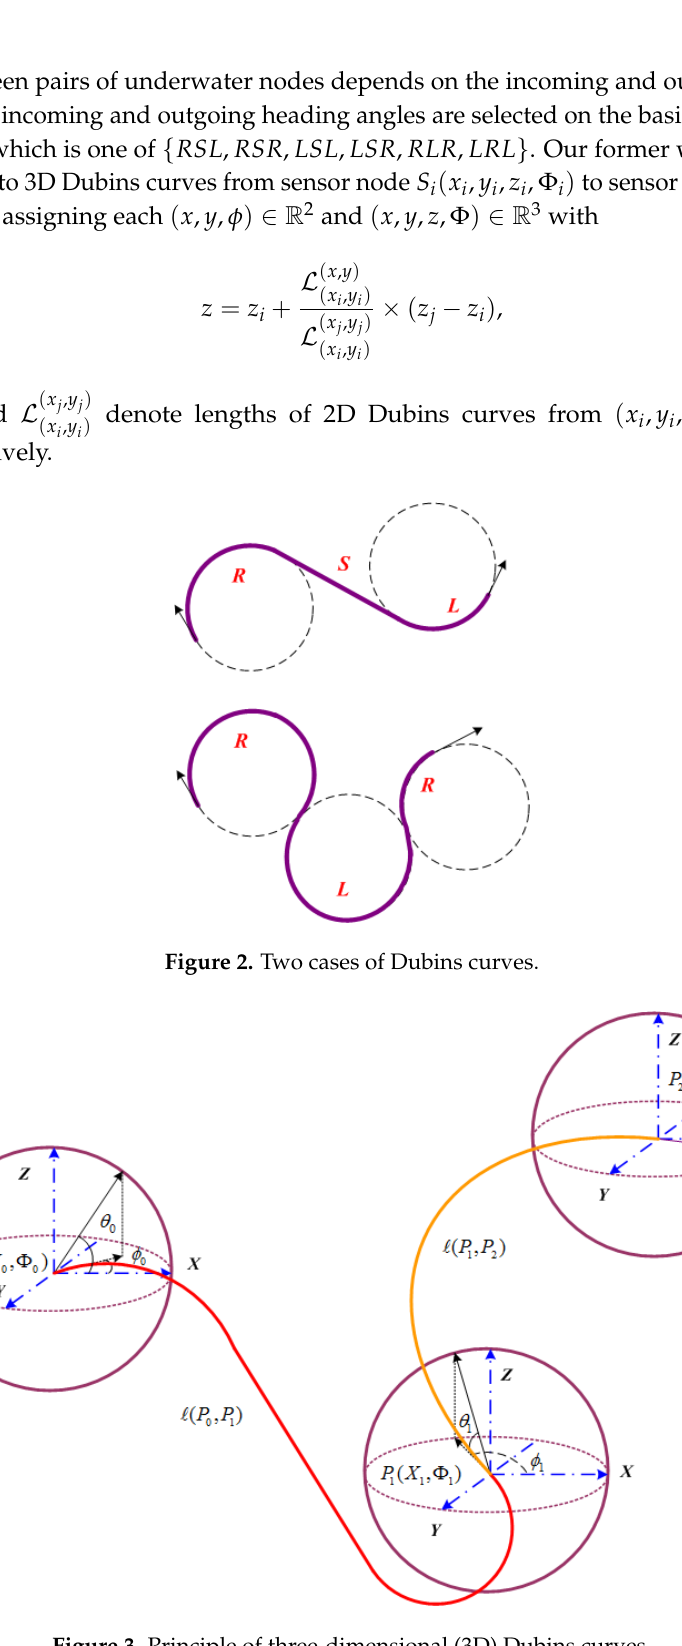
Figure 3. Principle of three-dimensional (3D) Dubins